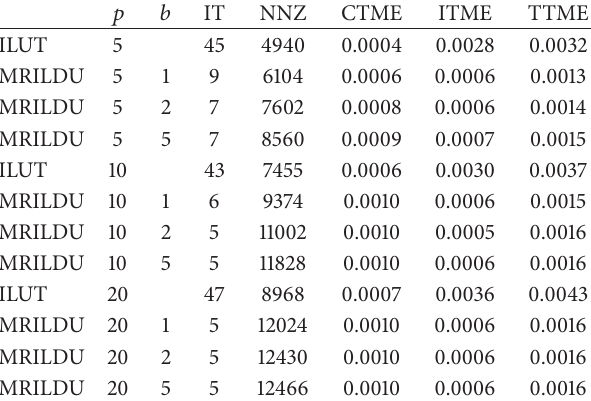
Table 11: Iteration results for matrix saylr3.